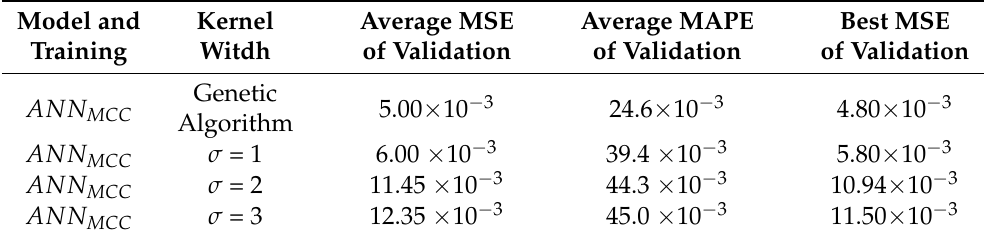
Table 2. Performance comparison of ANN models. State of Charge—Training result without the pres- ence of noise or